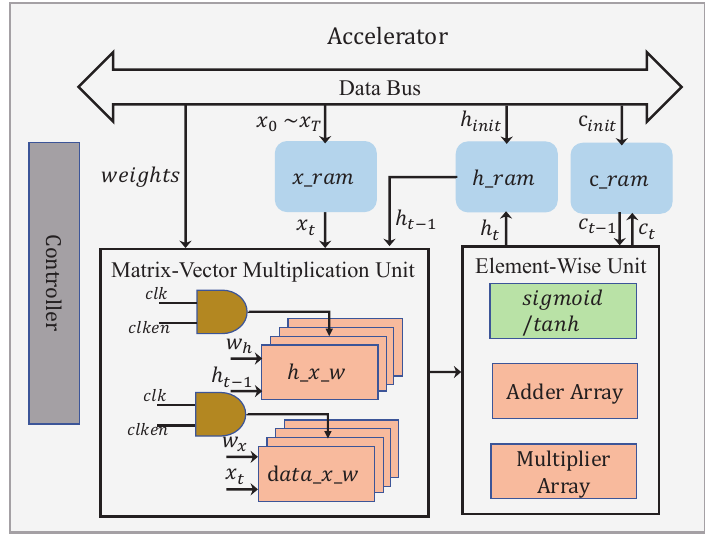
Figure 10. The overall architecture of the proposed accelerator.